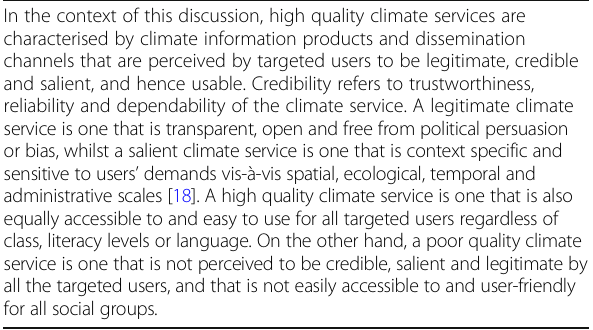
Table 1 High and poor quality climate information services In the context of this discussion, high quality climate services are characterised by climate information products and dissemination channels that are perceived by targeted users to be legitimate, credible and salient, and hence usable. Credibility refers to trustworthiness, reliability and dependability of the climate service. A legitimate climate service is one that is transparent, open and free from political persuasion or bias, whilst a salient climate service is one that is context specific and sensitive to users ’ demands vis-à-vis spatial, ecological, temporal and administrative scales [18]. A high quality climate service is one that is also equally accessible to and easy to use for all targeted users regardless of class, literacy levels or language. On the other hand, a poor quality climate service is one that is not perceived to be credible, salient and legitimate by all the targeted users, and that is not easily accessible to and user-friendly for all social